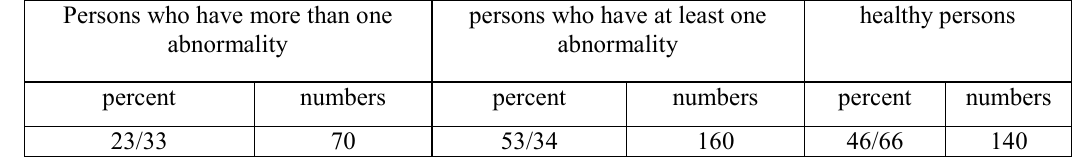
As it is shown in the table 1, 140 people (46/66%) of subjects were healthy and 160, 53/34%, had at least